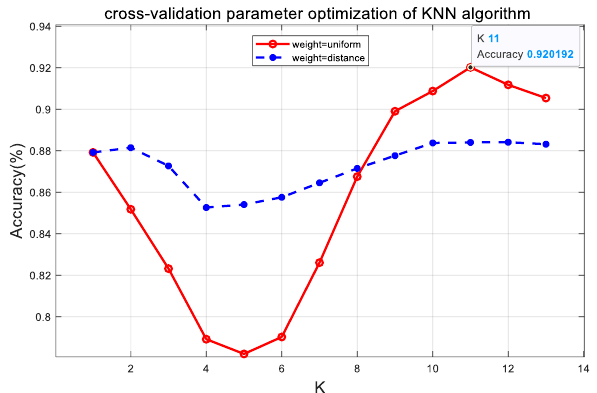
Figure 12. Cross-validation parameter optimization of KNN algorithm.